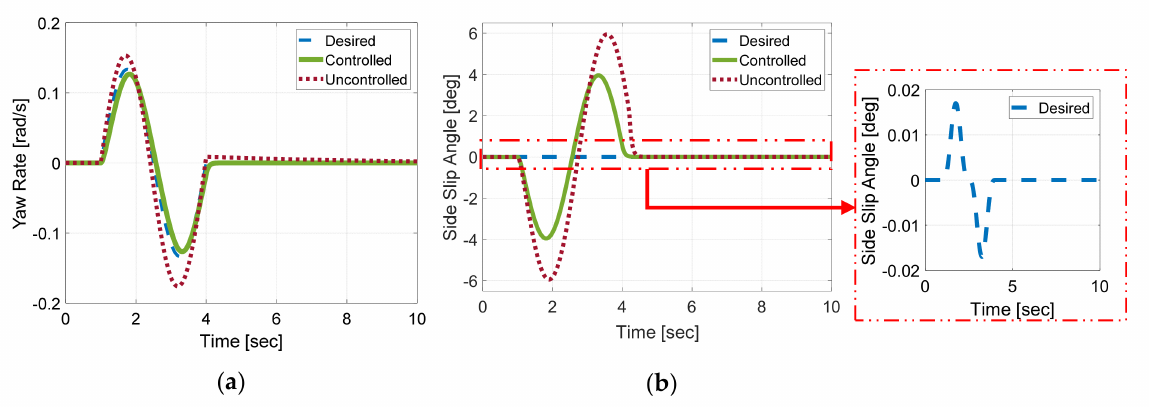
Figure 6. Comparison of regenerative electronic stability control (RESC), ( a ) with respect to yaw rates and ( b ) from sideslip angle for in-wheel layout with RESC.